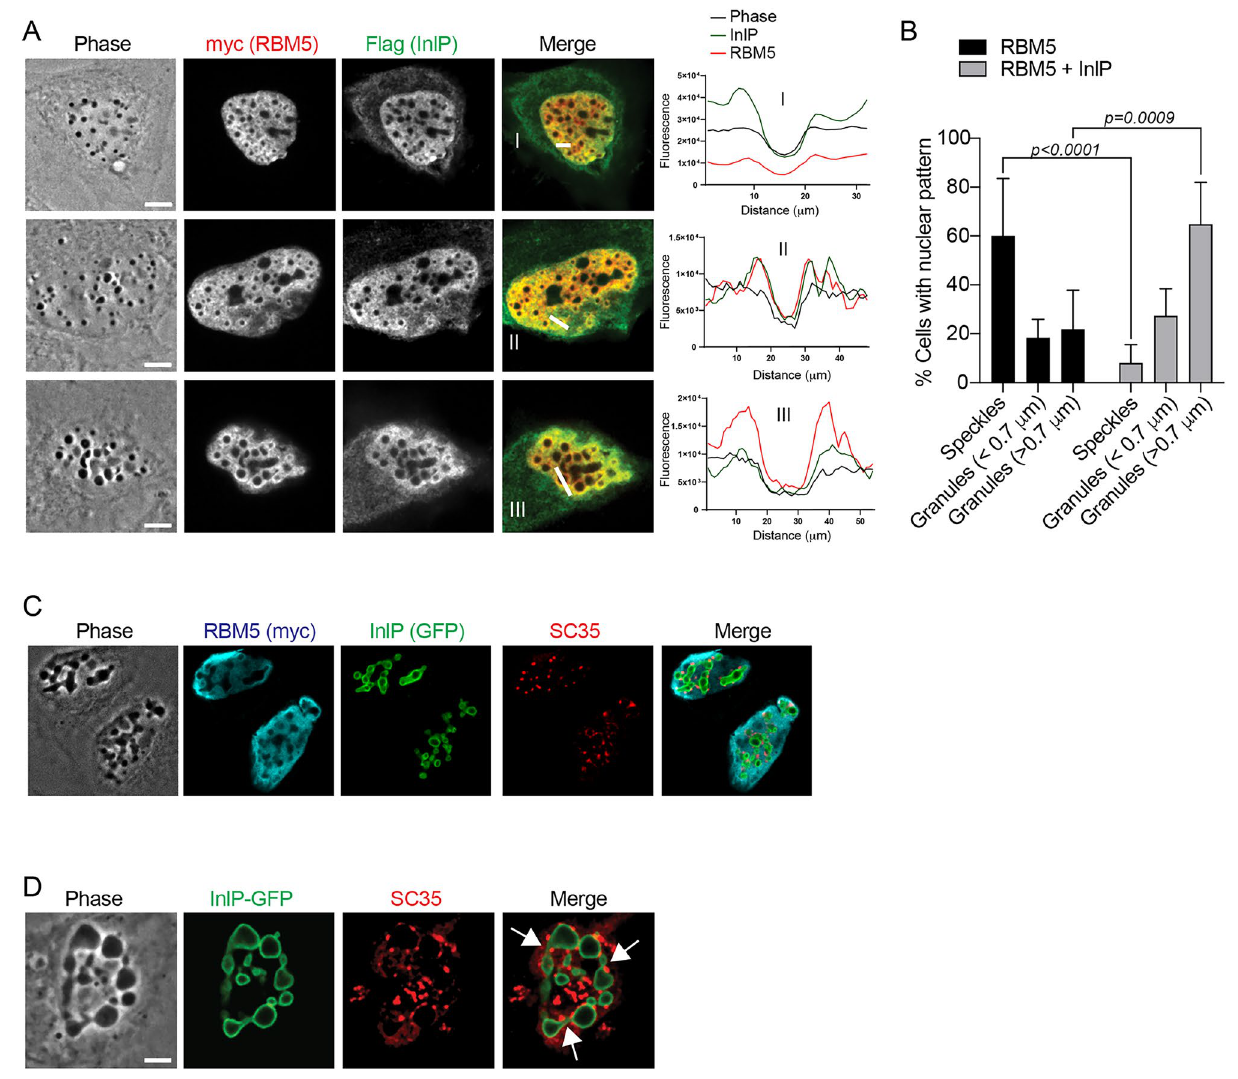
images of HeLa cells co-transfected with RBM5- Myc and InlP- HA (three examples are shown, with RBM5 condensates increasing in size); right, localization profile of RBM5 and InlP assessed with a line scan (white lines in the merged images) whose fluorescence intensity is plotted in red for RBM5, in green for InlP and in black for RBM5 granules; co-localization between RBM5 and SC35 is observed in I II, and III. ( B ) Nuclei with RBM5 speckles or RBM5 granules were scored in RBM5-expressing HeLa cells, in absence (black bars) or presence (grey bars) of InlP. Histograms represent percentage of each category as mean ± SD of 3 independent experiments. Statistical significance determined by ANOVA. ( C,D ) Representative phase contrast and immunofluorescence confocal microscopy images of HeLa cells co-expressing RBM5- Myc and GFP-InlP, immunolabeled with SC35 and RBM5 antibodies (A) or SC35 antibody (B). A nucleus with RBM5-condensates formed in presence of GFP-InlP is shown at higher magnification in (D). Arrows point to sites that show potential events of coalescence or fission. Scale bars: 10